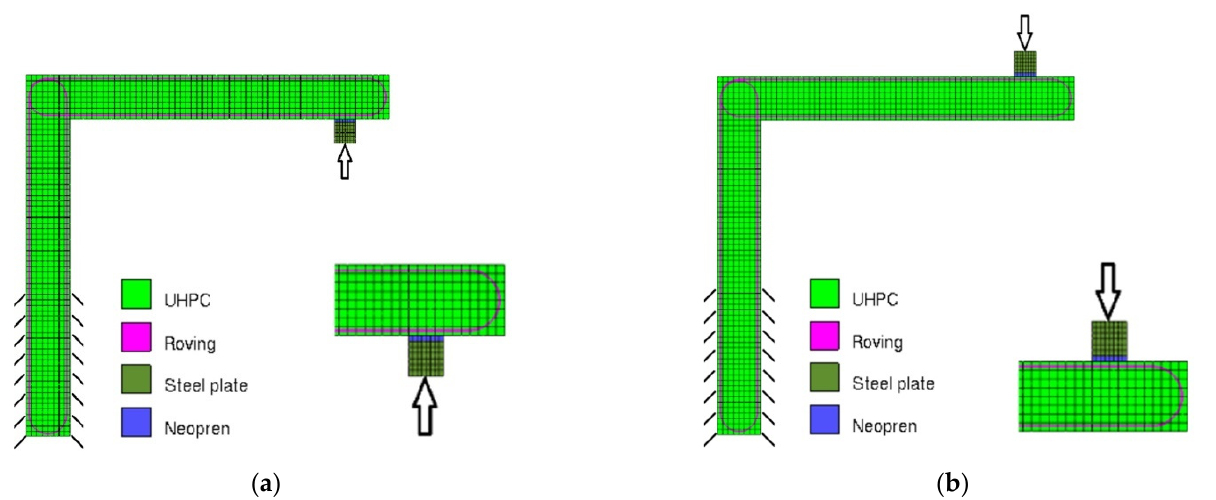
Figure 6. The numerical model of the rigid frame in Atena Engineering software with detailed view of the area of loading support: rigid frame opening ( a ); rigid frame closing ( b ). The arrows mark the position of the loading force.